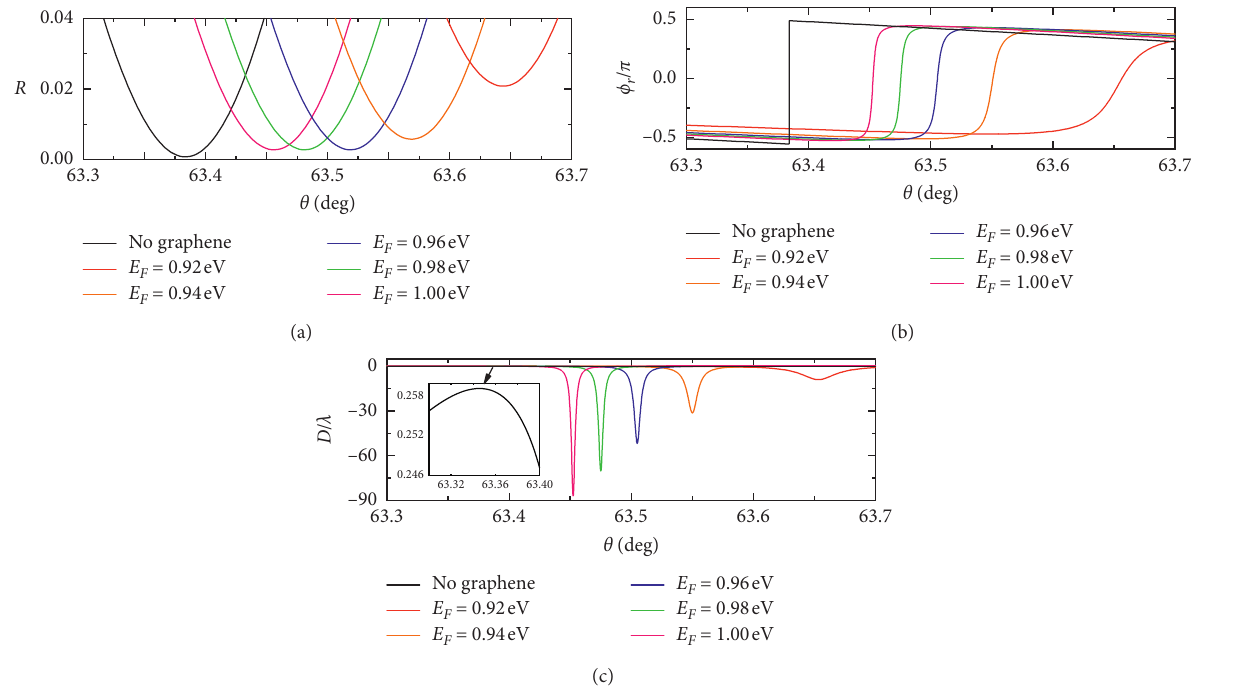
Figure 2: The dependence of the reflectivity (a), reflection phase (b), and GH shift (c) on the incident angle at different Fermi energies, respectively.